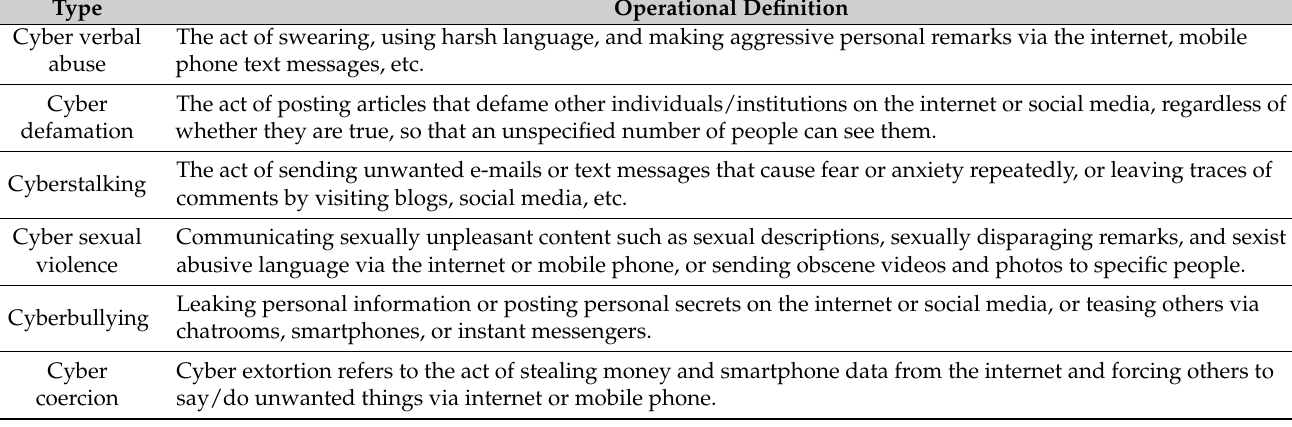
Table 1. Operational definitions of cyberbullying.